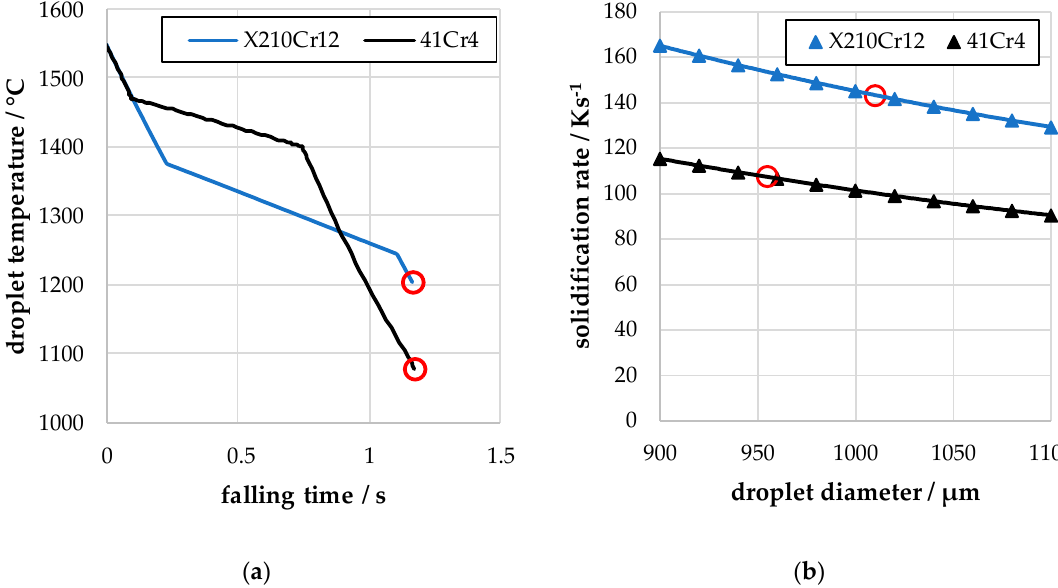
Figure 6. ( a ) Calculated thermal histories from droplet cooling model for experimental process conditions and a falling distance of 6.5 m red circles indicate impact time in quenchant. ( b ) Average solidification rates for both alloys, red circles mark experimental conditions.